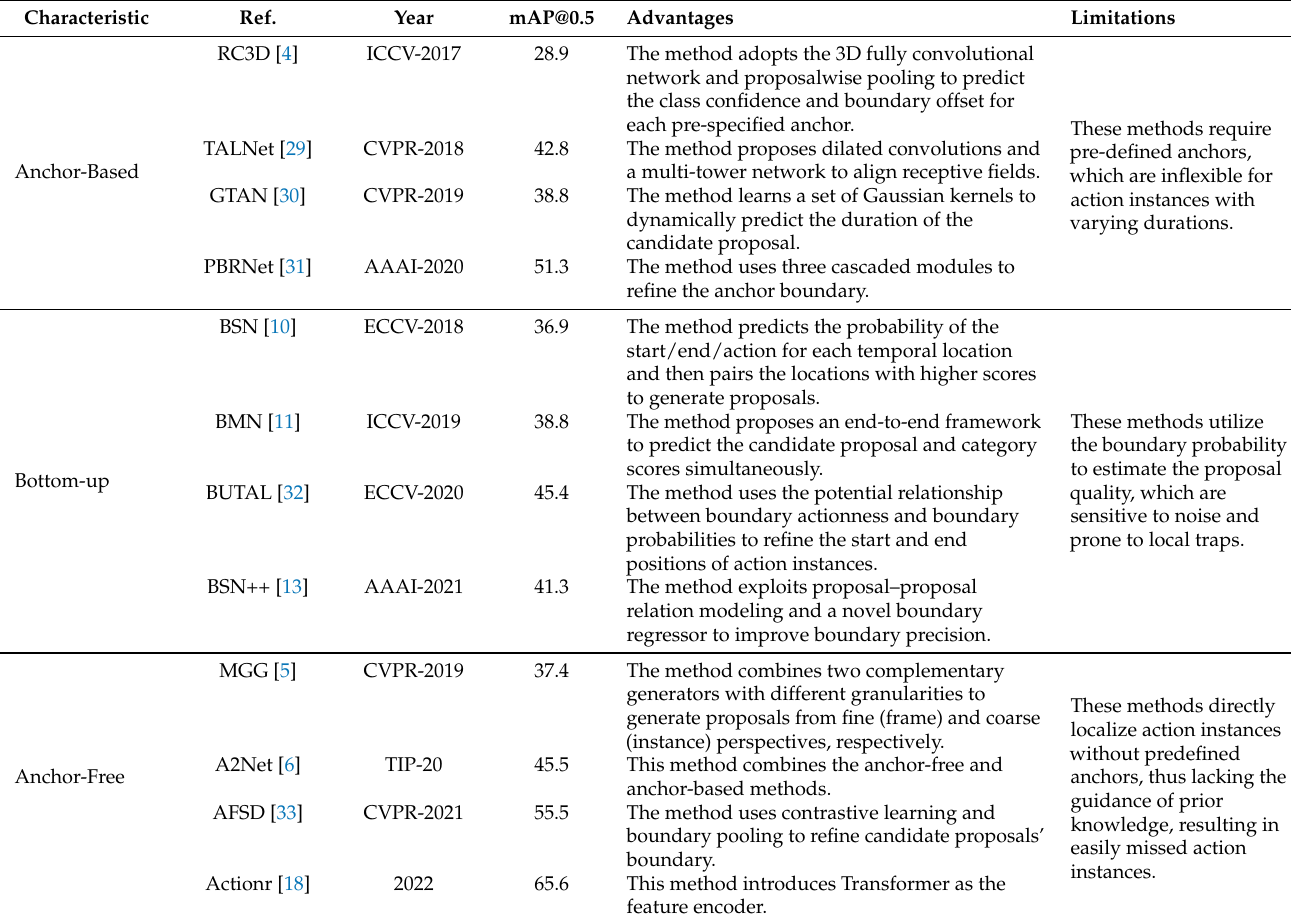
Table 1. Summary of some representative temporal action detection